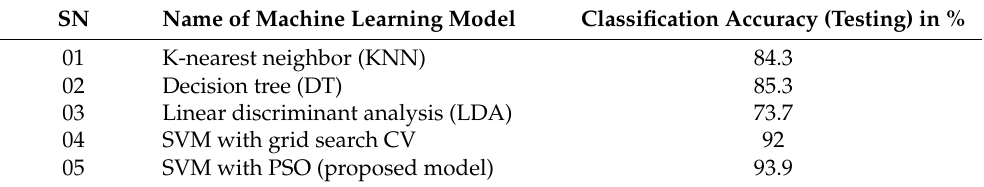
Table 4. Comparative analysis of the proposed model with other